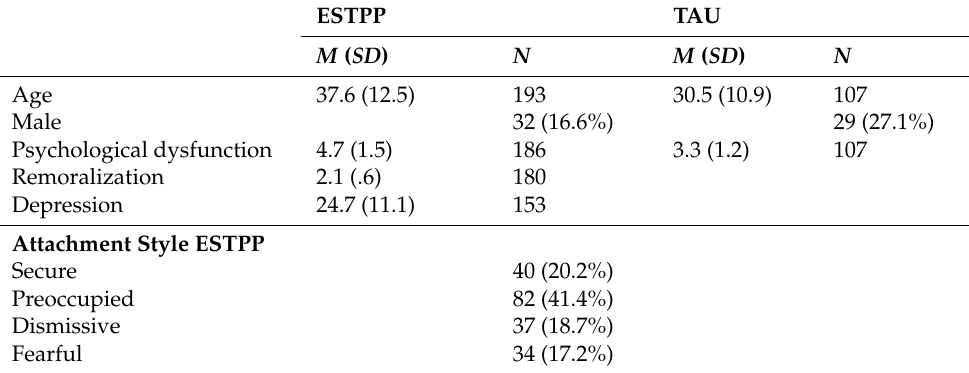
Table 3. Descriptive of the study population at baseline (T0 for ESTPP and T1 for TAU).